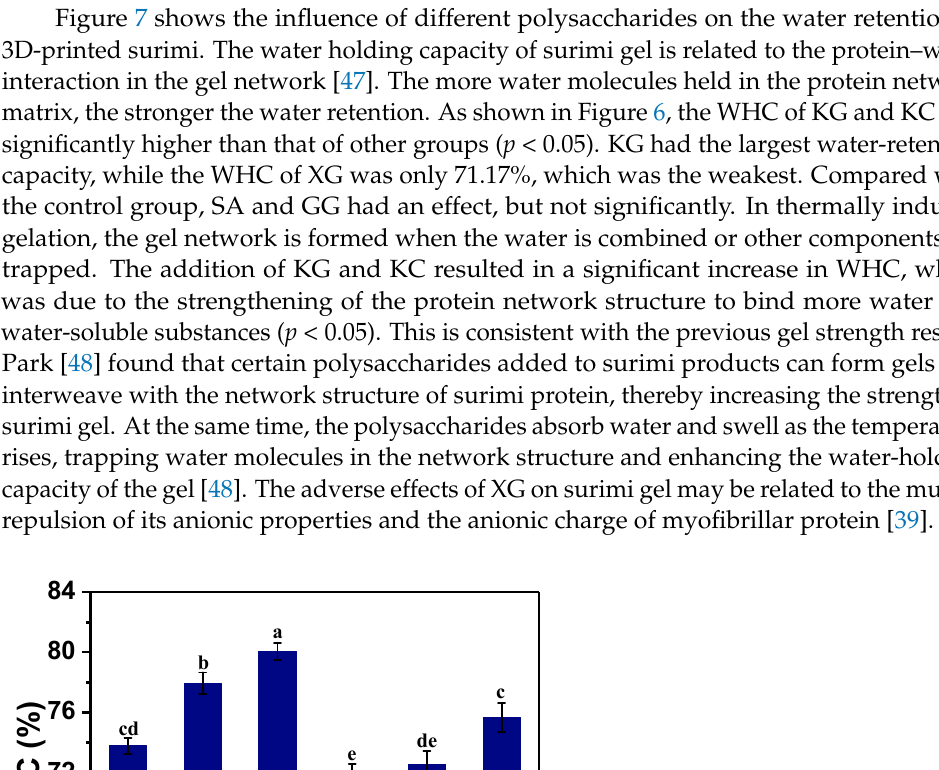
Table 2. Texture profile analysis (TPA) indicators for 3D-printed cylindrical surimi after cooking.